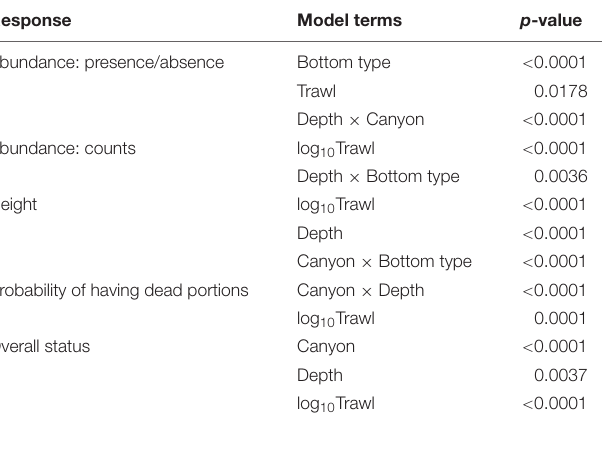
TABLE 3 | Significant terms in models predicting abundance, height, and status of Keratoisis grayi colonies from ROV surveys off the Grand Banks, Newfoundland.